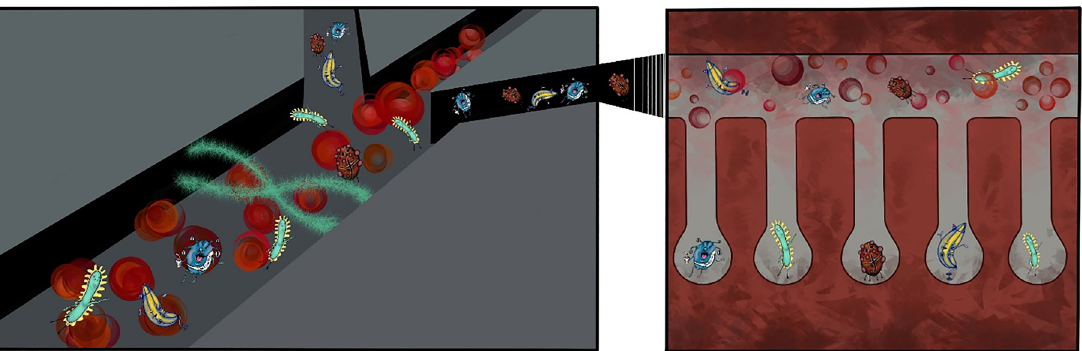
Figure 21: Illustration of the microfluidic platform based on surface acoustic waves (SAW) – with indicated pressure node (green sinusoid) – sorting fl owing bacteria directly from blood to dedicated micro fl uidic chip with microchambers (left and right channels) for further bacteria recognition and consequent analysis under de fi ned antibiotic. Red blood cells, white blood cells, and platelets are directed to the middle channel. In the chip parallel laminar fl ows of the cultivation medium and antibiotic solution of known concentration can be maintained along with the use of optical tweezers to manipulate and sort identi fi ed cell to the different chambers. Illustration on the right shows micro fl uidic chip with microchambers which shows how identi fi ed bacteria can be placed to the separate microchambers for further detailed analysis either with SERS or with Raman spectroscopy. Figure courtesy of Gabriela